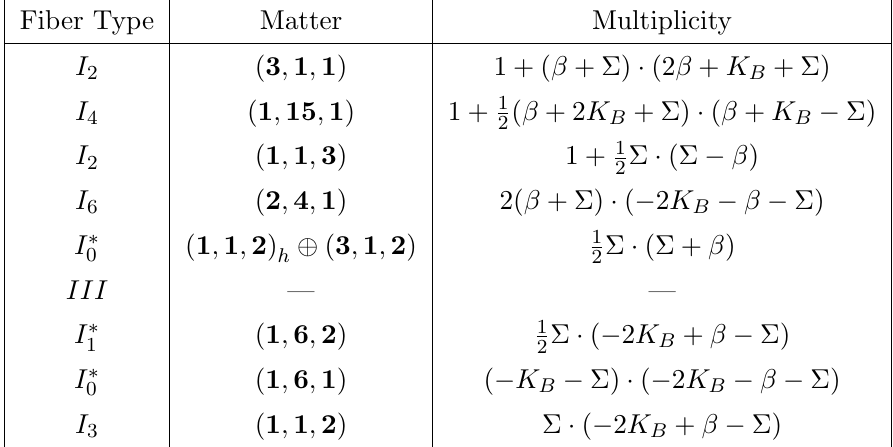
Table 2 . The matter multiplicities in the F-theory compacti(cid:12)cation to 6D on the Calabi-Yau elliptic (cid:12)bration (2.15). The (cid:12)rst three rows correspond to the adjoint hypermultiplets arising as deformation modes of the codimension one components of the discriminant; the remaining rows are localized codimension two